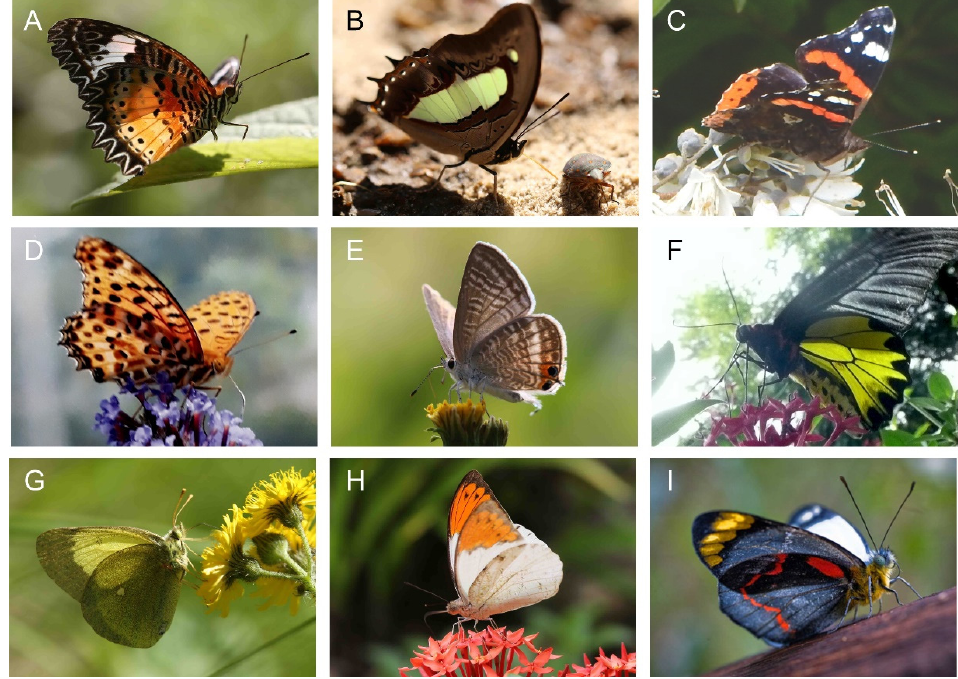
Figure 3. Butterflies with translucent wings illuminated from above: ( A ) Cethosia penthesilea Cramer, 1777; ( B ) Polyura athamas Drury, 1773; ( C ) Vanessa atalanta Linnaeus, 1758; ( D ) Argyreus hyperbius Linnaeus, 1763; ( E ) Lampides boethius Linnaeus, 1767; ( F ) Troides aeacus Felder and Felder, 1860; ( G ) Colias palaeno orientalis Staudinger, 1892; ( H ) Hebomoia glaucippe Linnaeus, 1758; ( I ) Delias nigrina Fabricius, 1775.